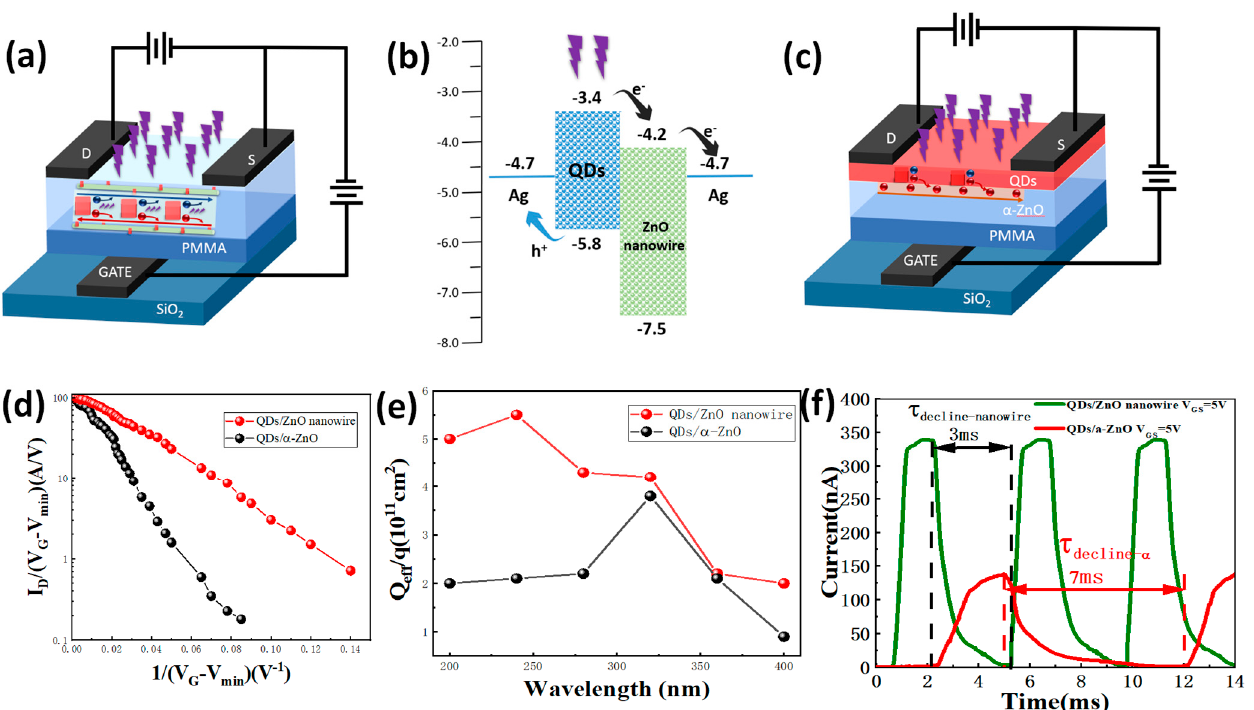
Figure 3. ( a , c ) Comparison chart of the QDs/ZnO nanowire PT and QDs/ α -ZnO PT (hereinafter referred to as nanowire-PT and α -PT); ( b ) band diagram and charge transfer diagram of the hybrid material; ( d ) semilogarithmic plot of I D /(V G − V min ) versus 1/(V G − V min ) for the phototransistor with or without incident light (270 nm, peak power = 5 µW/cm 2 ); ( e ) efficient light-induced carrier density stored in optical transistors at various UV wavelengths; ( f ) comparison of the nanowire-PT and α -PT’s light signal responses at 270 nm and 5 µW/cm 2 under a 5 V gate voltage.